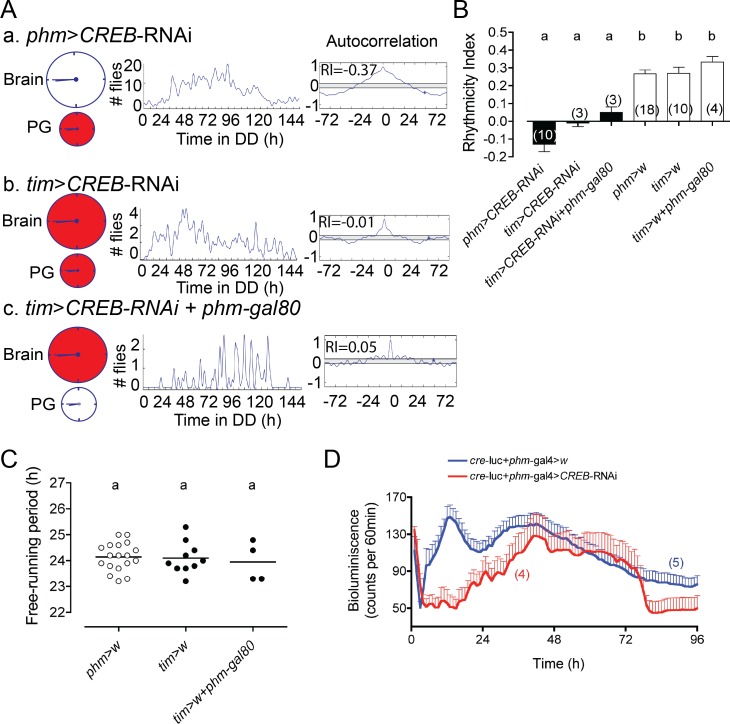
Knockdown of CREB in PG and/or central clocks causes arrhythmicity of eclosion.(A) Pattern of eclosion under DD following knockdown of CREB in the PG (a), in all clock cells (b), and in all clock cells except for the PG (c). Schematic shown on the left represents the brain and the PG clocks (large and small circle, respectively); red indicates where CREB was knocked down; middle: pattern of eclosion in DD; right: autocorrelation analysis of record, with dominant value of RI indicated. (B) Average rhythmicity index (RI) values (± SEM) for results shown in A and for controls; different letters indicate statistically different groups (p<0.05; one-way ANOVA, Tukey’s post hoc multiple comparison analyses). Numbers in parenthesis indicate number of separate experiments. (C) Free-running periodicity for controls (experimental groups, shown in A, were arrhythmic; cf., B). Each circle indicates results from a separate experiment; average is indicated by horizontal line; different letters indicate statistically different groups (p<0.05; one-way ANOVA, Tukey’s post hoc multiple comparison analyses). (D) Knockdown of CREB in the PG renders arrhythmic the pattern of cre-driven bioluminescence. Values plotted correspond to average ± SEM; numbers in parenthesis indicate number of records averaged.